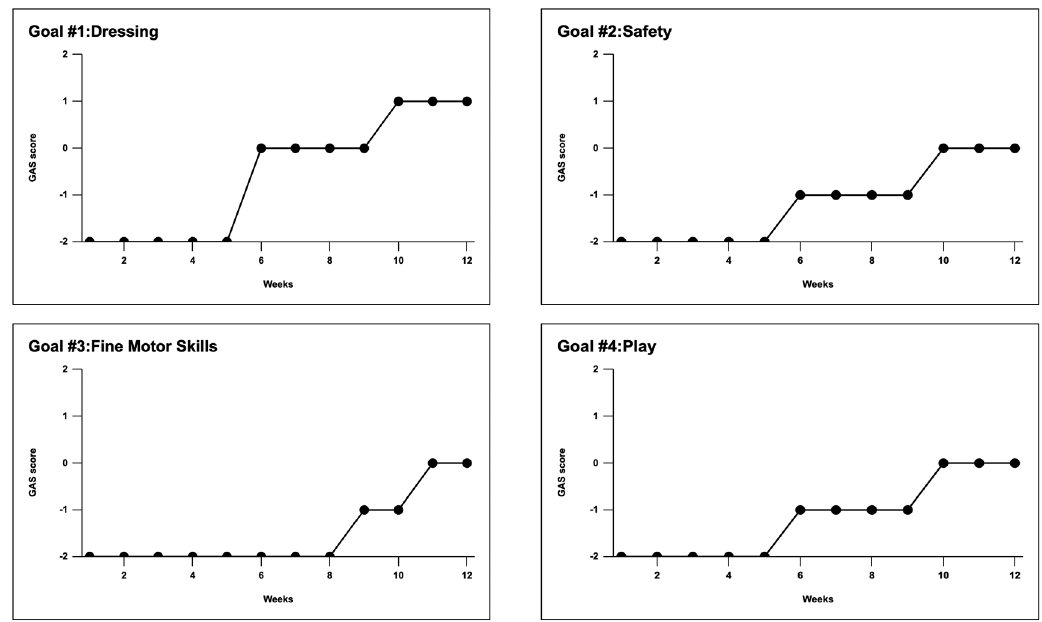
Figure 3. Goals and goal attainment scales. L demonstrated visible improvements in all